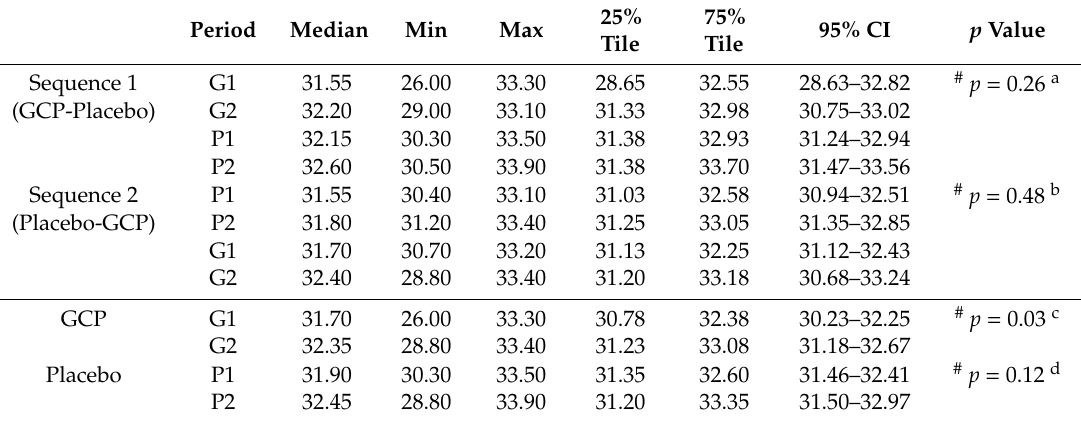
Table 2. Moisture level of the lingual mucosa (%).